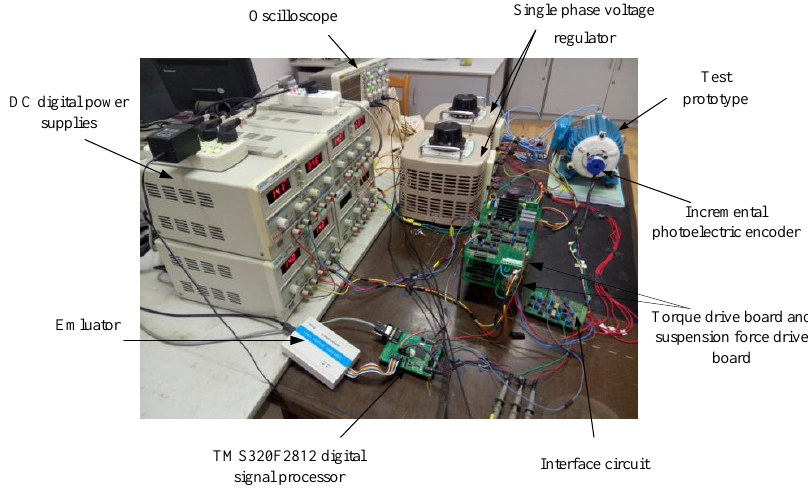
Figure 14. SBPMSM experimental platform using digital control system.